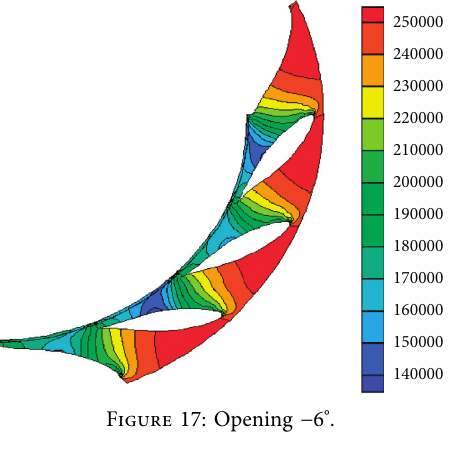
Figure 17: Opening − 6 ° .